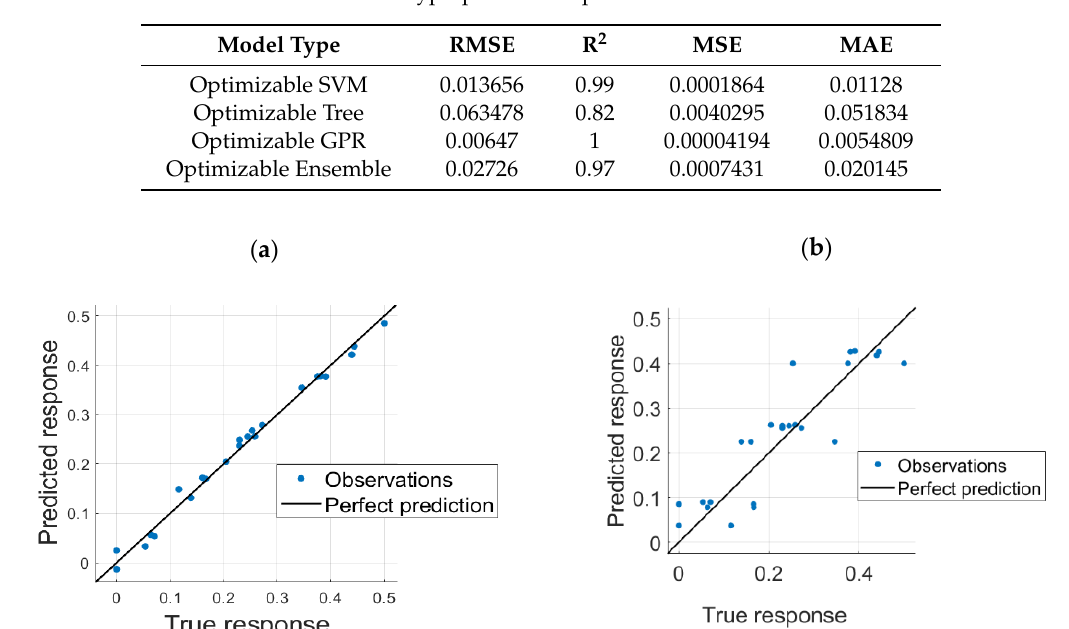
Table 5. Combinations of hyperparameter optimization models error measures.